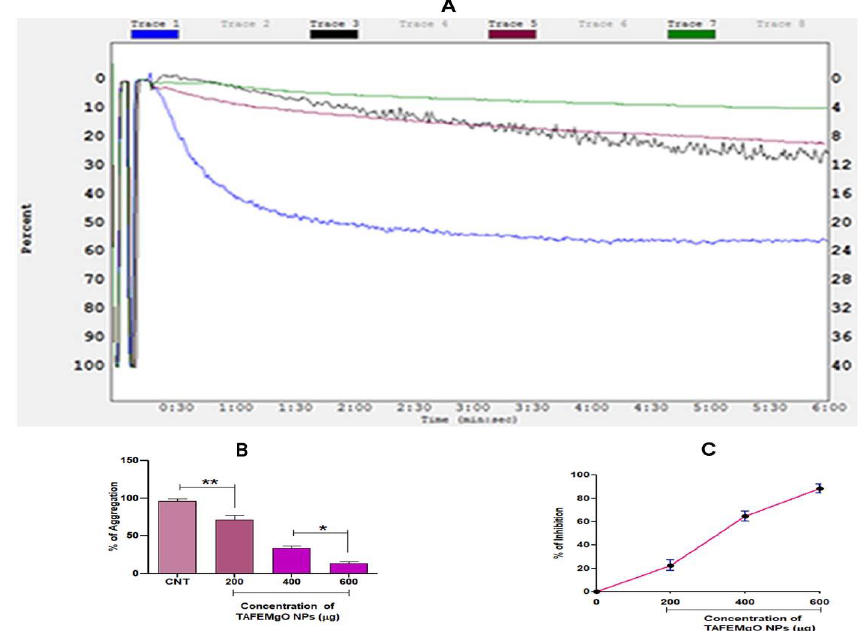
Figure 8. The impact of TAFEMgO NPs on ADP-agonist-induced platelet aggregation: ( A ) platelet aggregation traces: trace 1ADP 10 M; trace 2-ADP 10 M + 200 μ g TAFEMgO NPs; trace 3ADP 10 M + 400 μ g TAFEMgO NPs; and trace 4ADP 10 M + 600 μ g TAFEMgO NPs. All the values represented were measured from three experiments and presented as mean ± SD. ( B ) percent platelet aggrega- tion (%) in dose-dependent manner, ( C ) percent platelet aggregation inhibition (%) in dose-depend- ent manner. * Significance at p 0.005, ** at p 0.001 and *** at p 0.0001. 2.8. TAFEMgO NPs Are Nontoxic Biogenic Molecules TAFEMgO NPs did not induce hemolysis in the red blood cells and were not found to induce any hemorrhagic and paw-edema like toxic and inflammatory responses in the experimental mice (data not shown). This indicated the nontoxic nature of TAFEMgO NPs. Figure 9 indicates the effect of TAFEMgO NPs on red blood cells.